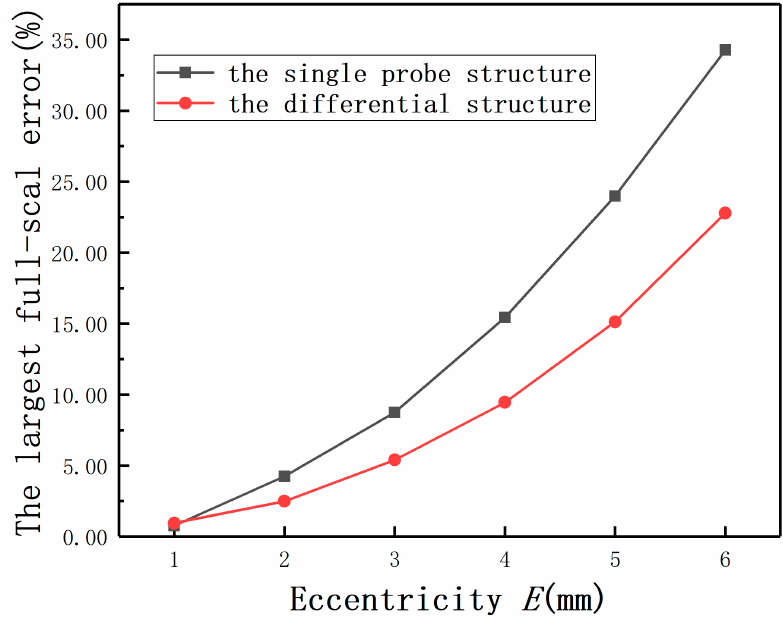
Figure 25. The largest full-scale errors with different eccentricities.